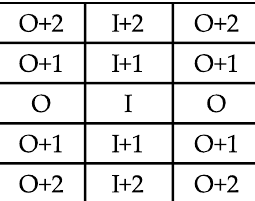
Figure 1. Diagram of the positions of the 14 neighbouring vines distributed around an infected vine (I). I + 1: first neighbour within the same row, I + 2: second neighbour within the same row, O: opposite vine within the next row, O + 1: first neighbour of the opposite vine within the next row, O + 2: second neighbour of the opposite vine within the next row.